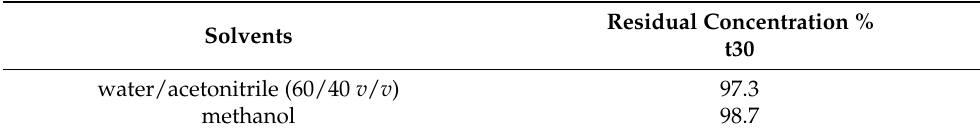
Table 2. H 2 S-DOXO stability in water/acetonitrile and in methanol, expressed as a residual concen- tration